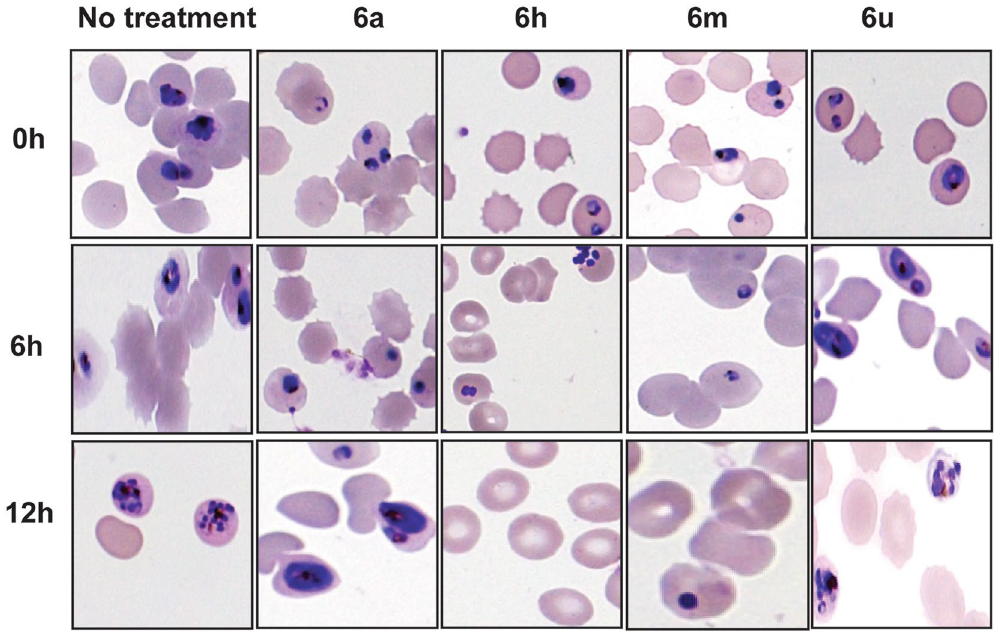
Figure 4. Micrographs of P. falciparum trophozoite stages treated with Pht analogues. Note: Illustration of Pht analogues treatment effect on early (rings) and mature (trophozoites and schizonts) parasite blood stages. (All treatments were performed in parallel to a no treatment